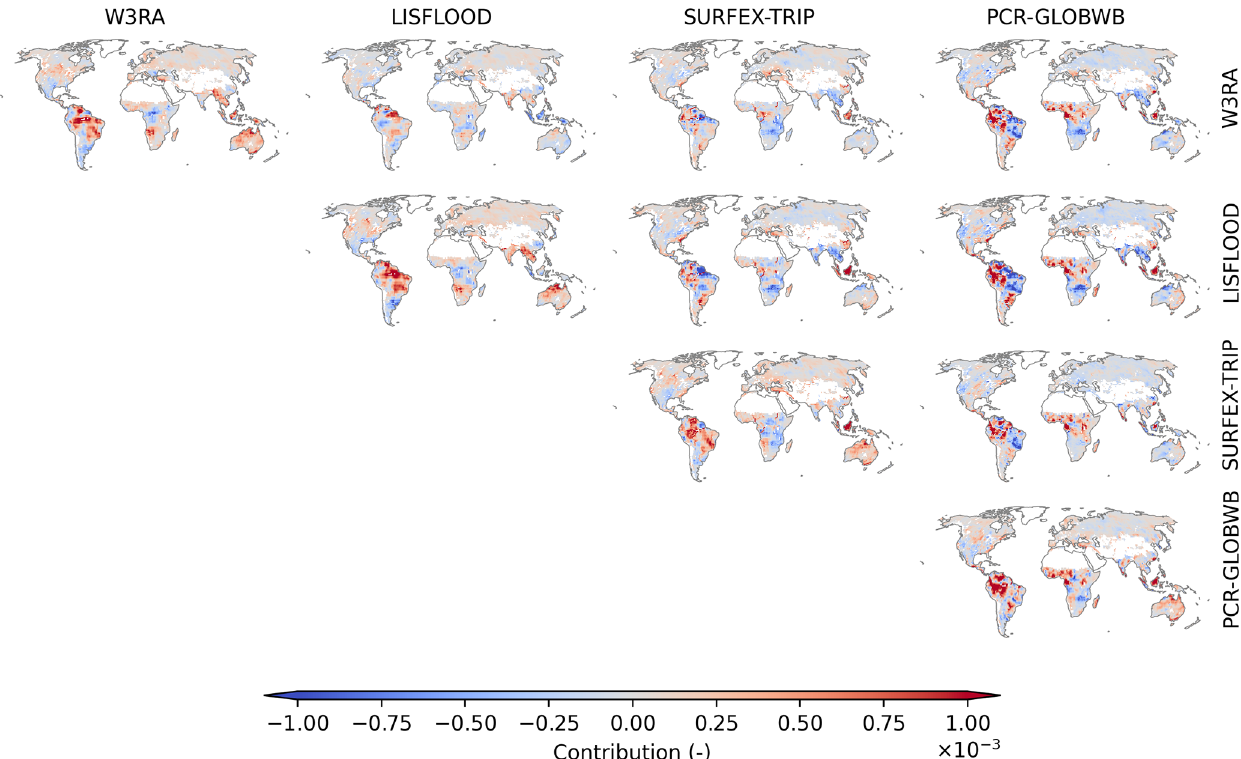
Figure B15. Global distribution of pixel-wise contributions to the variance in the modeling error in global terrestrial water storage interannual variability by selected global hydrological models from the eartH2Observe ensemble (Schellekens et al., 2017). Along the diagonal, maps of the pixel-wise contribution to the global TWS IAV modeling errors in W3RA, LISFLOOD, SURFEX-TRIP, and PCR-GLOBWB are shown. Above the diagonal, a map of the difference (i.e., column − row) is shown. For example, the map of the first row and the second column is for LISFLOOD (column) minus W3RA (row). White pixels within land boundaries are the regions masked out in this study (see Appendix A).